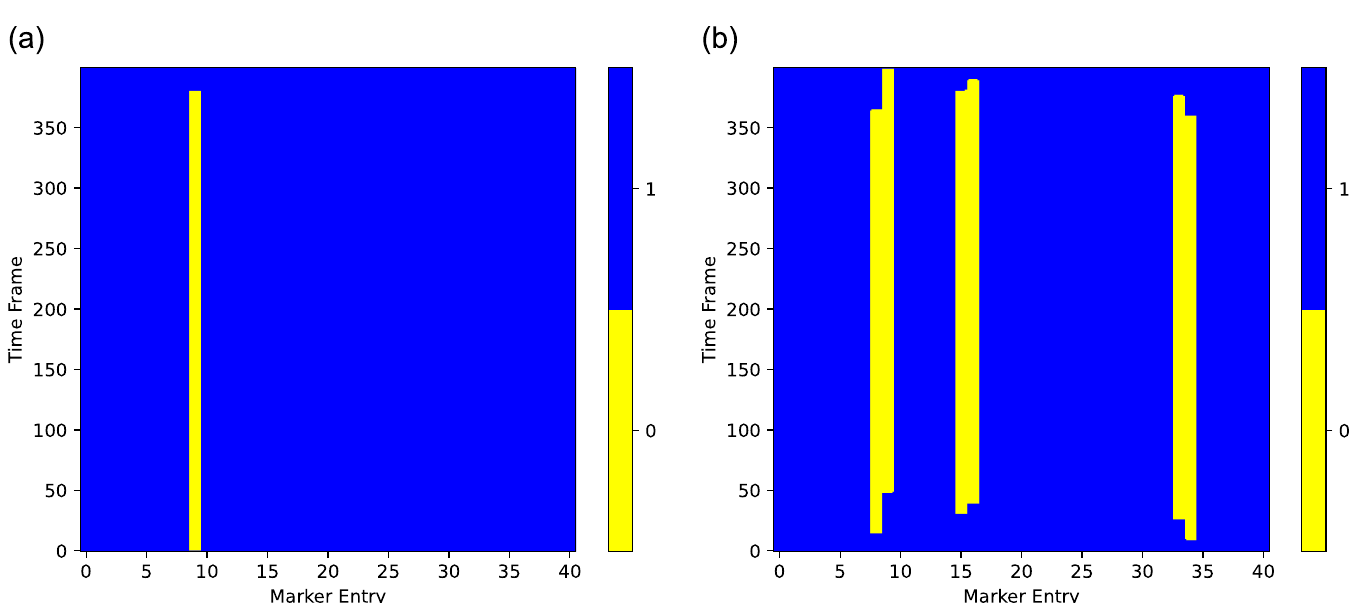
Fig 1. Examples of missing a single marker and multiple markers in a sample. YELLOW indicates gaps. (a) a single gap in HDM dataset. (b) multiple gaps in HDM dataset.